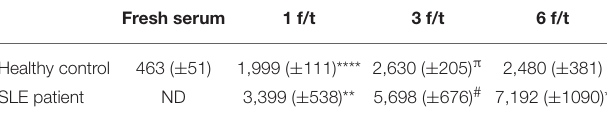
TABLE 3 | C3(H 2 O) levels in healthy controls (HC) and SLE patient sera.